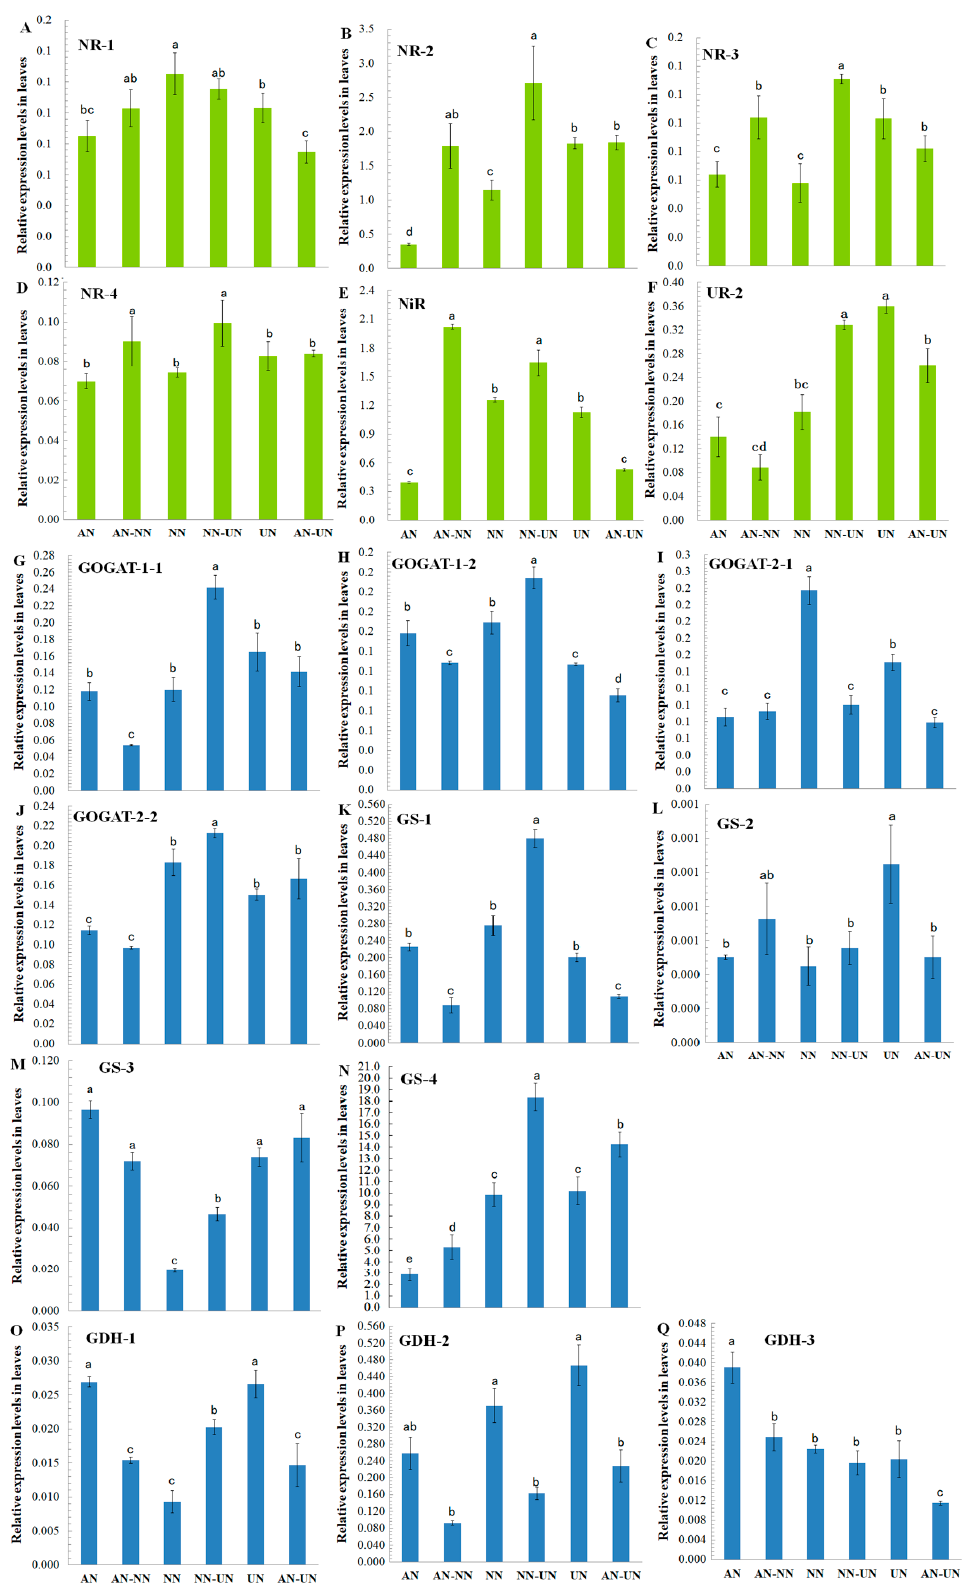
Figure 4. The expression profiles of genes involved in metabolizing nitrogen in cucumber. ( A ) NR-1; ( B ) NR-2; ( C ) NR-3; ( D ) NR-4; ( E ) NiR; ( F ) UR-2; ( G ) GOGAT-1-1; ( H ) GOGAT-1-2; ( I ) GOGAT-2-1; ( J ) GOGAT-2-2; ( K ) GS-1; ( L ) GS-2; ( M ) GS-3; ( N ) GS-4; ( O ) GDH-1; ( P ) GDH-2; ( Q ) GDH-3. Bars represent the standard error. Di ff erent letters above the bars indicate significant di ff erences at p < 0.05 according to Tukey’s multiple comparison